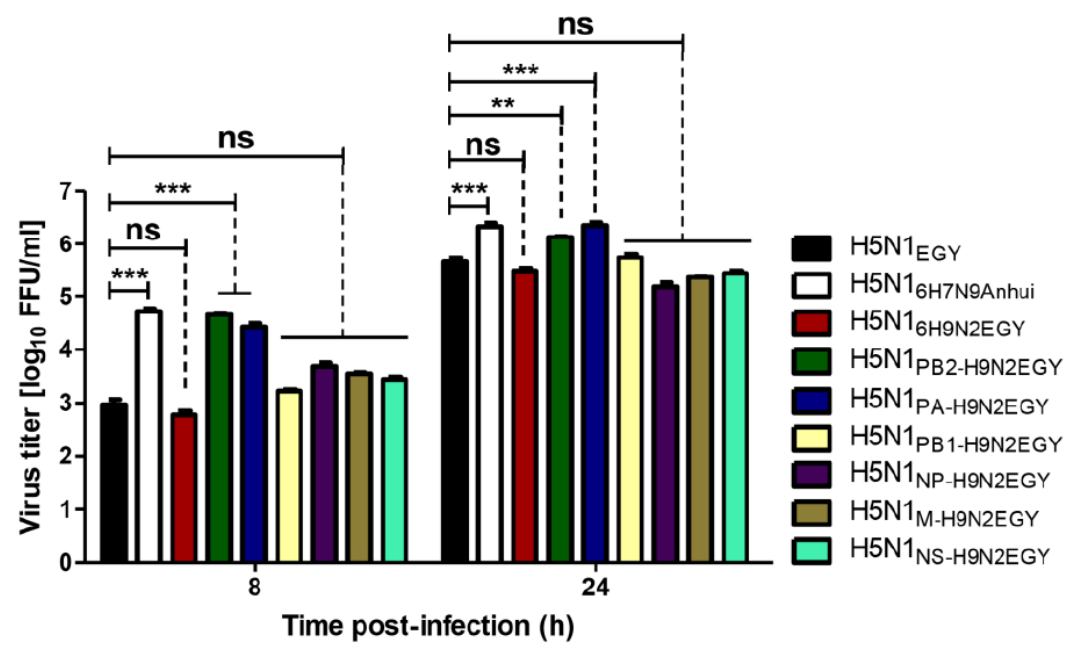
Figure 2. Replication efficiency of the H5N1 EGY reassortants. Mammalian Madin-Darby canine kidney (MDCK-II) cells were infected (in triplicate) with H5N1 EGY reassortants expressing internal proteins-encoding H9N2 EGY genes or with the wild-type H5N1 EGY or the control H5N1 6H7N9Anhui virus at MOI of 0.01, cultured at 37 °C for single replication cycle (8 h) and multiple replication cycles (24 h) p.i. Subsequently the virus titers were determined. Error bars reflect standard deviation (SD) of three independent experiments. Statistical analysis was performed using repeated measures ANOVA, followed by Bonferroni post hoc test. The significant differences are indicated (** = p < 0.01, *** = p < 0.001 and non-significant = ns).